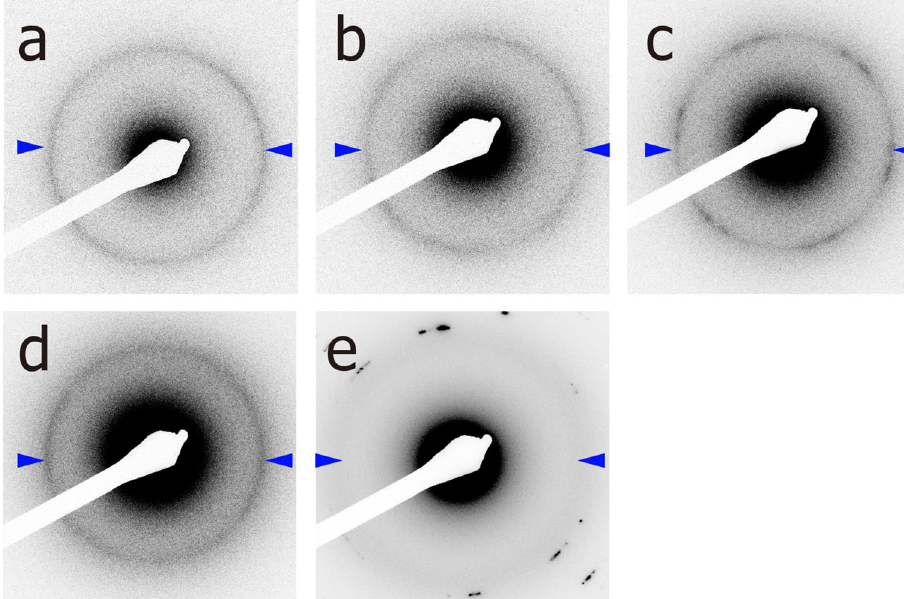
Figure 2. ED patterns from the DSPC monolayer at different electron fluxes; ( a ) 0.9 e/nm 2 ·s, ( b ) 2.3 e/nm 2 ·s, ( c ) 4.7 e/nm 2 ·s, ( d ) 15.9 e/nm 2 ·s, and ( e ) 30.0 e/nm 2 ·s. The DSPC monolayer was formed on a collodion-coated